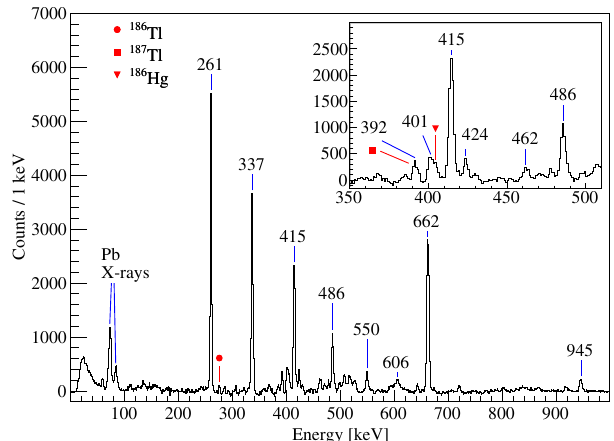
Fig. 1 Recoil-gated, α -tagged background-subtracted γ -ray energy spectrum. The most prominent peaks are marked with transition energies. The inset shows a close-up of the energy region from 350 to 510 keV. The contaminant transitions and their parent nuclei are marked with the red